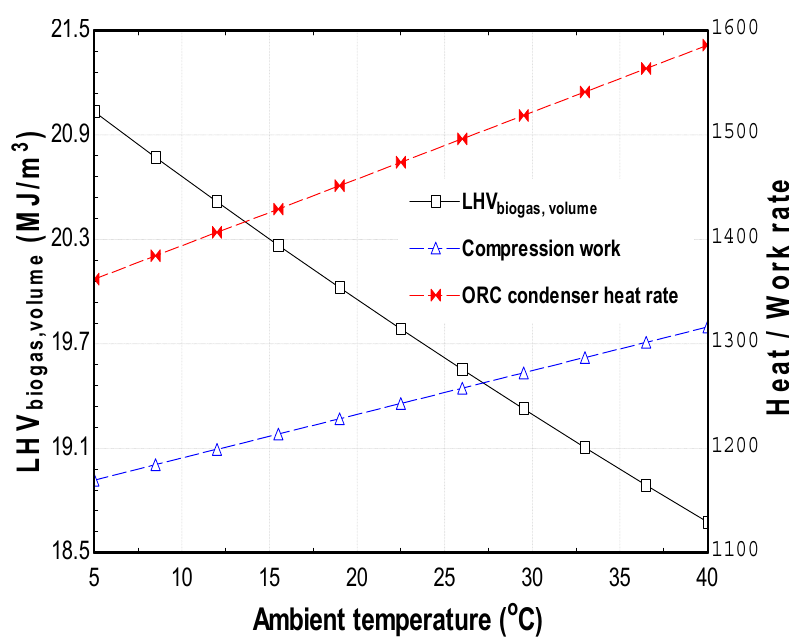
Figure 11. Effect of the ambient temperature on the LHV, compression work, and the ORC condenser heat rate.